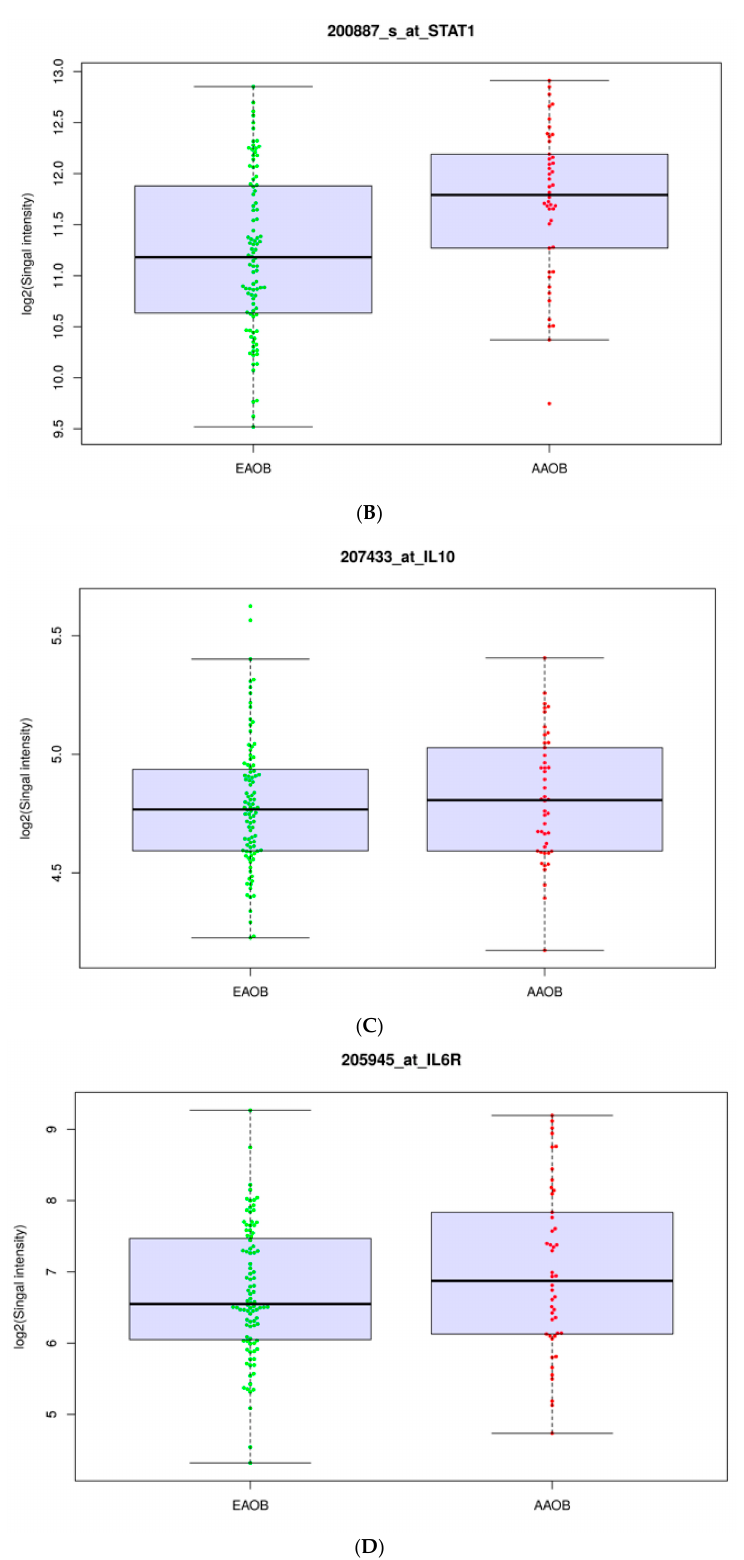
Figure 1. Boxplots of specific interferon signaling genes expressed in African-American obese patients compared to European-American obese patients under gene expression number GSE79858. ( A ) Boxplot of IFNG expression in obese African-Americans (AAOB) compared to obese European- Americans (EAOB). ( B ) Boxplot of STAT1 expression in AAOB vs. EAOB. ( C ) Boxplot of IL10 expression in AAOB vs. EAOB. ( D ) Boxplot of IL6R in AAOB vs.